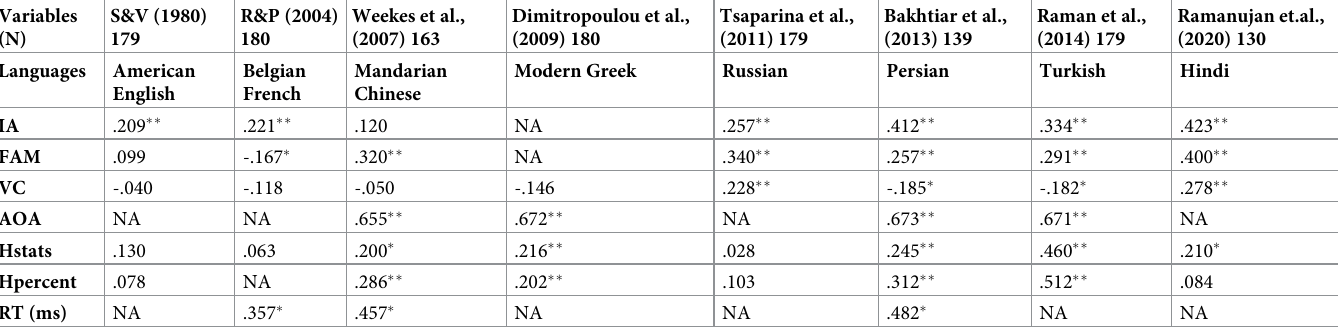
Table 6. Comparison of psycholinguistic variables of present study with original black and white line drawing and similar studies which have used colourised ver- sion of Snodgrass and Vanderwart pictures. Variables